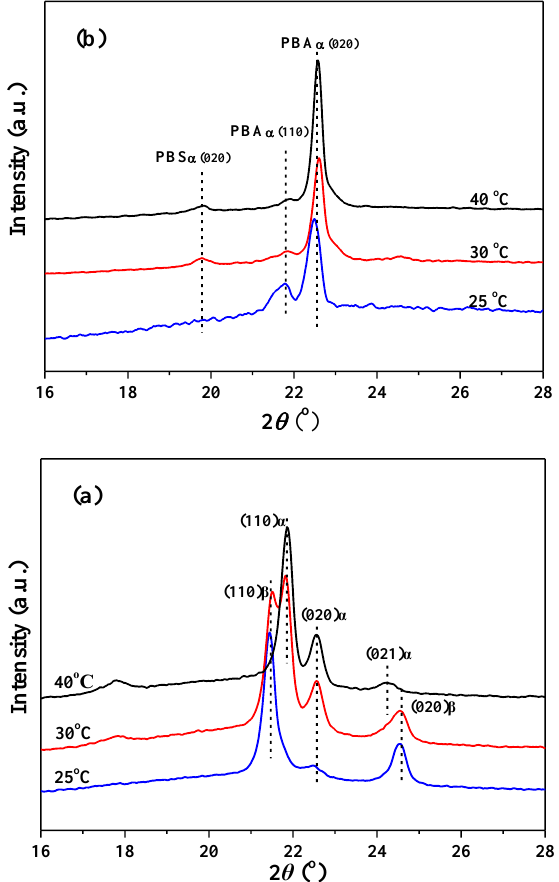
Figure 5. WAXD images of PBA crystallized on ( a ) glass and ( b ) PBS substrates at different